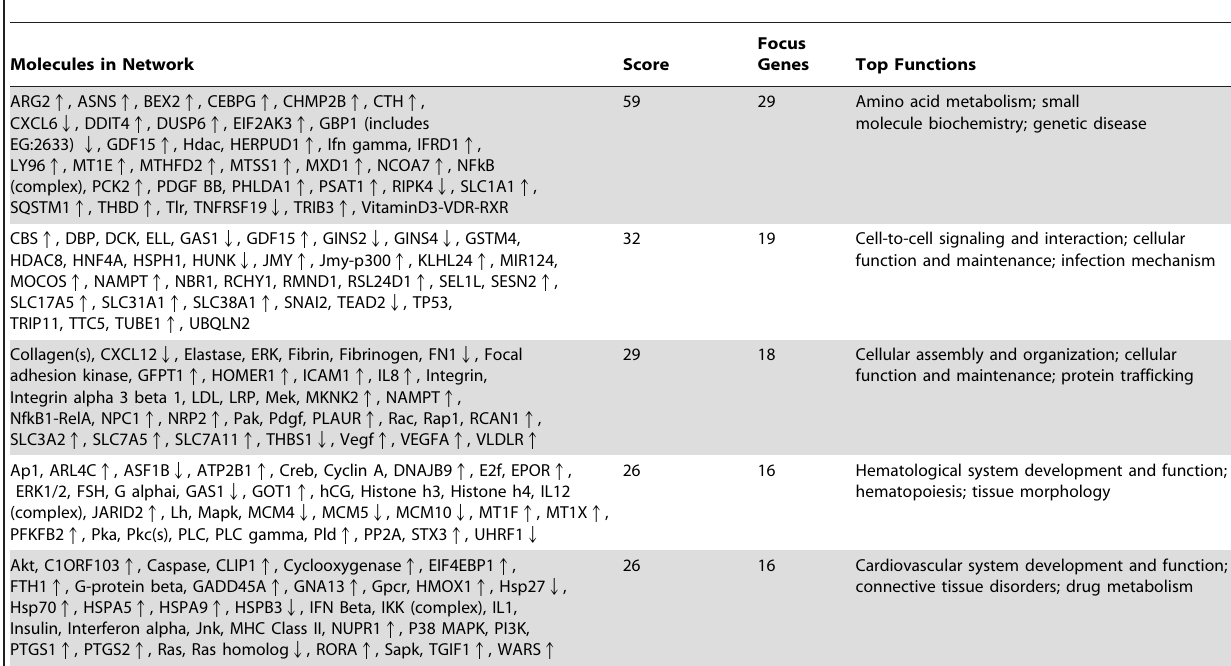
Table 5. Selected genetic networks with high scores ( . 26) in SSc Control vs SSc Rottlerin-exposed human dermal fibroblasts.